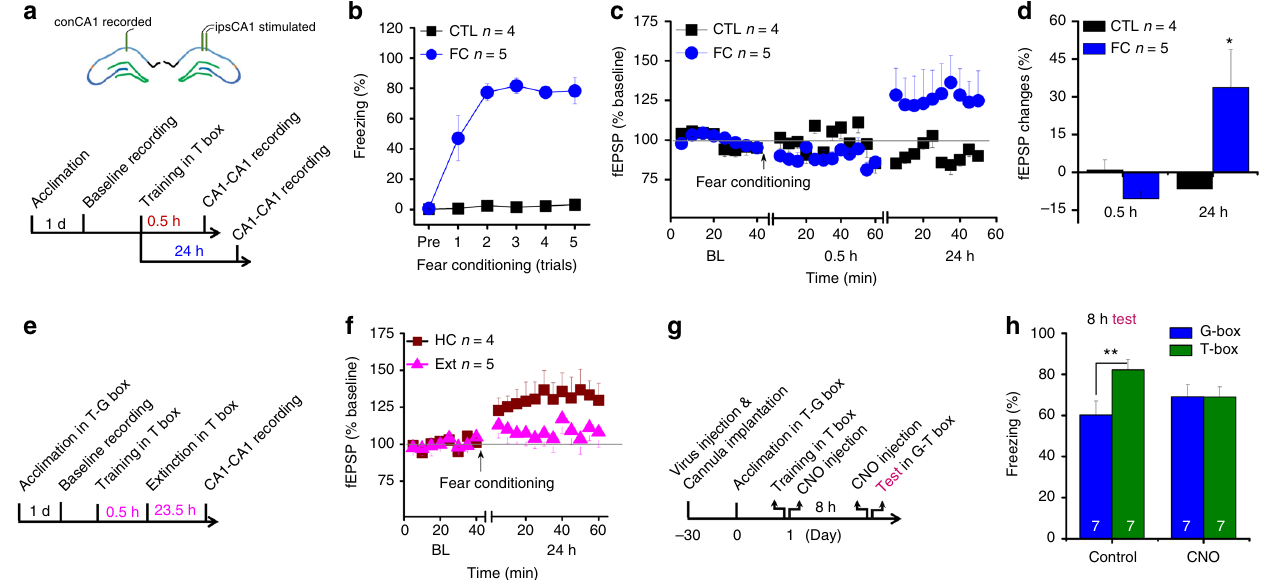
Fig. 4 The ipsCA1 – conCA1 synaptic ef fi cacy is readjusted selectively for generalization. a , b After 40-min baseline recordings for ispCA1-conCA1 fEPSP, animals were subjected to fear conditioning (FC). Control animals (CTL) were exposed to the training box without footshocks. c , d No difference from baseline (BL) was detected at 0.5 h after FC, but a reliable synaptic potentiation was found to be developed over 24 h after FC when generalization was well developed. e , f No difference from BL was found at 24 h after FC if extinction training (Ext) was applied at 0.5 h to disrupt generalization formation, while a synaptic potentiation at 24 h after FC was observed in homecage animals (HC) without Ext. g , h AAV-hsyn-hM3Dq-mCitrine was injected into ipsCA1, while guide cannula was implanted into conCA1. Application of clozapine-N-oxide (CNO group) twice, immediately after fear conditioning and 30 min before retrieval tests at 8 h via the guide cannula, enhanced generalization in a similar box (G-box), up to the levels almost equivalent to that in the training box (T-box). Without CNO treatment (saline control), the scores in G-box were signi fi cantly lower than that in T-box. Statistical comparisons are performed by using repeated one-way ANOVA d , f or two-way ANOVA h ; * P < 0.05, ** P < 0.01. Error bars, s.e.m. ipsCA1, ipsilateral CA1;